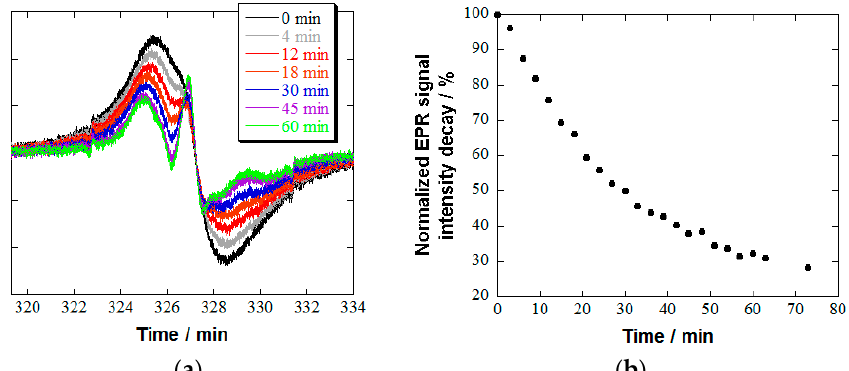
Figure 5. ( a ) Time-course of EPR spectra and ( b ) the reduction resistance of 4 14 in 2 / 4 14 to a large excess of ascorbic acid (20 equiv based on 4 14 ) in PBS at 25 ° C. The normalized signal intensity decay was evaluated by a double-integration method. See the Supplementary Information for experimental details.